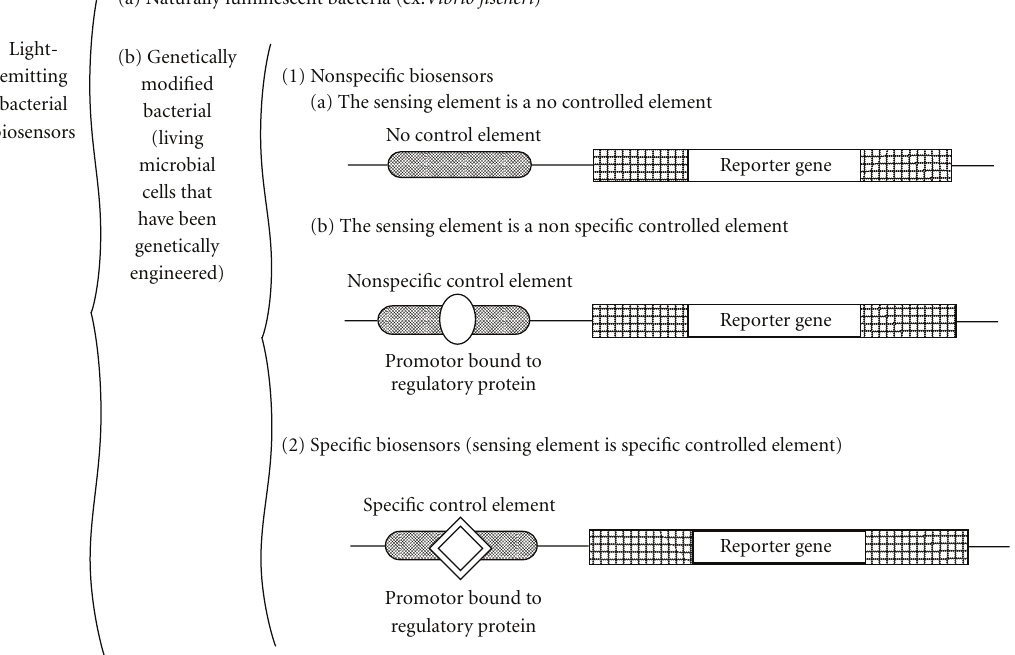
Figure 2: Classification of light-emitting bacterial